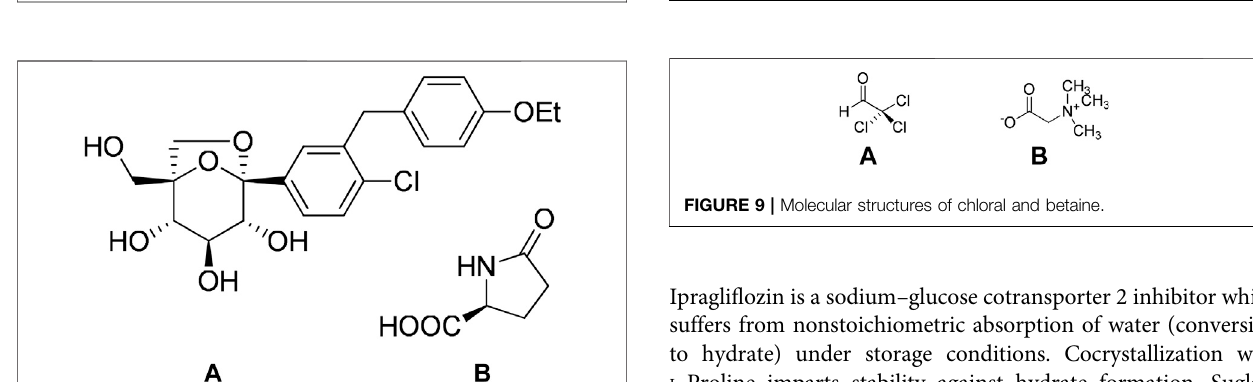
FIGURE 8 | Molecular structures of A. escitalopram and B. oxalic acid.